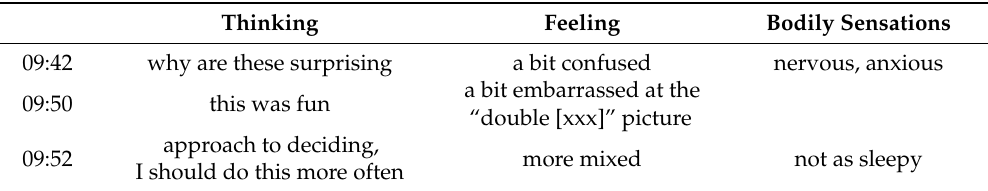
Table 2. Participant 4’s micro diary.